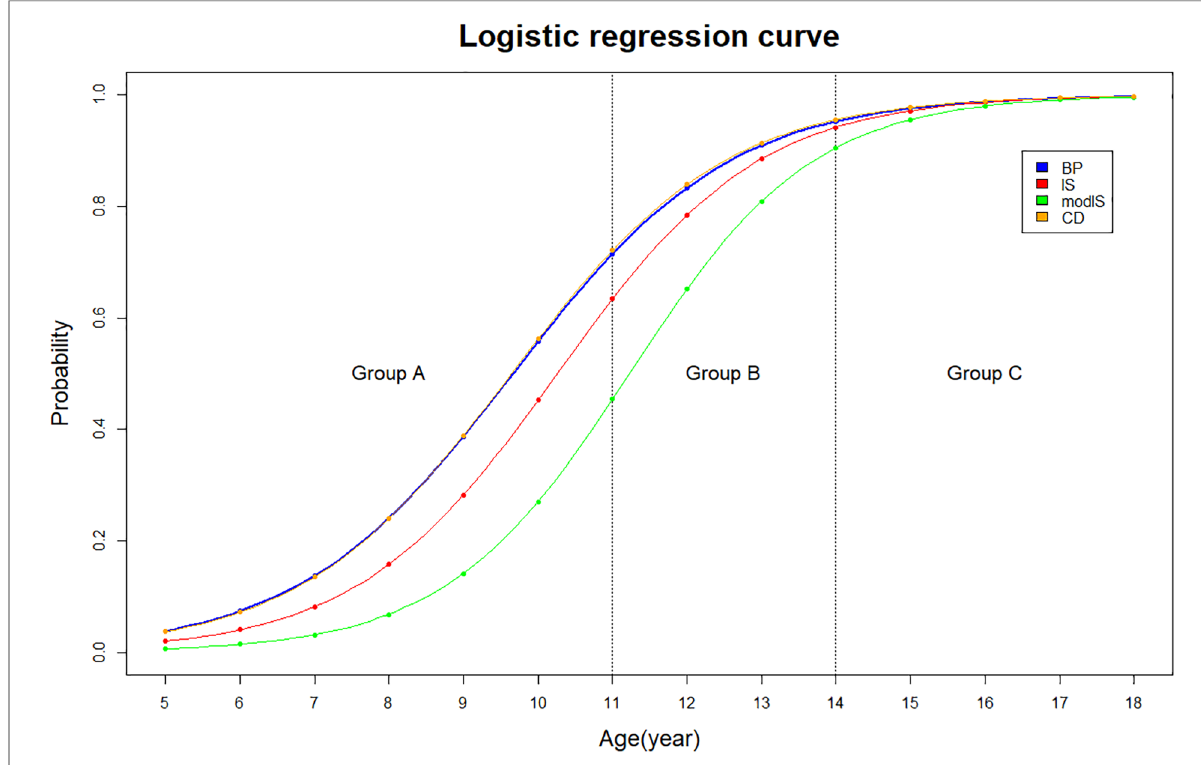
FIGURE 2 Logistic regression curve of the applicable probability regarding each measurement